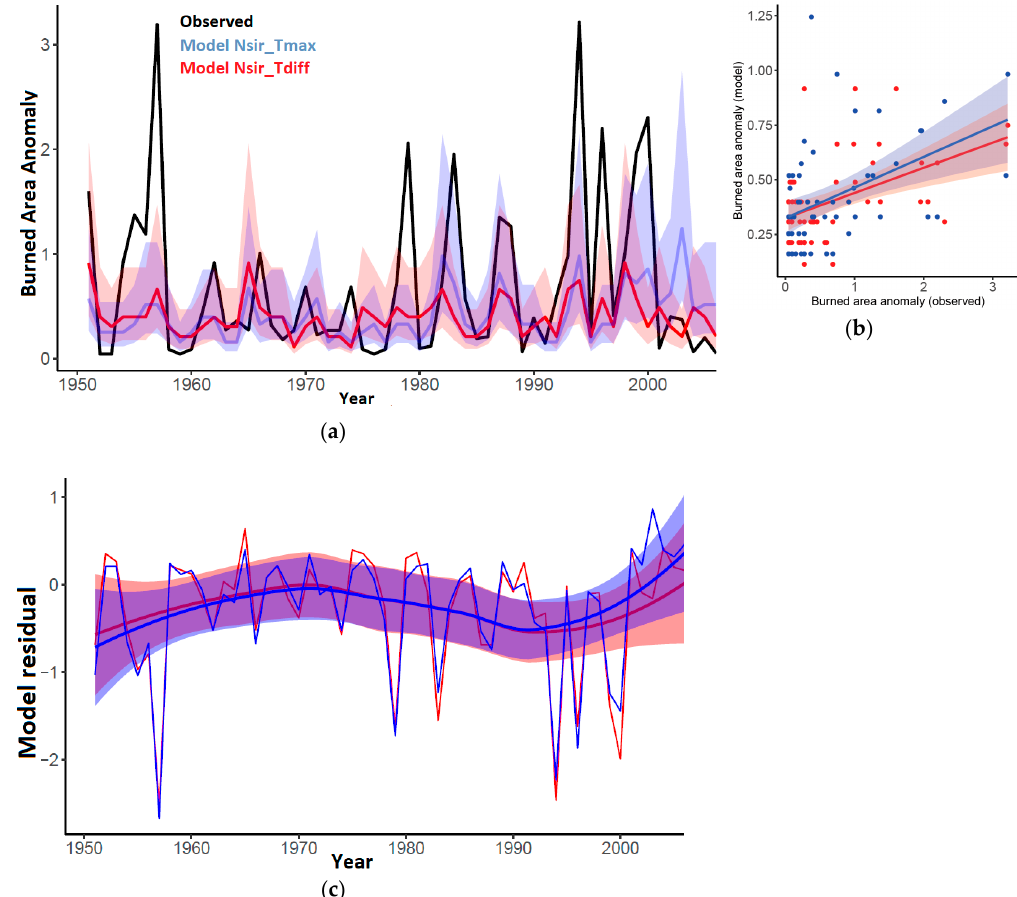
Figure 5. ( a ) Yearly burned area anomaly from 1950 to 2006 from observed data (black line) and simulated with the number of Sirocco events based on temperature anomaly (Nsir_Tdiff red line) and temperature threshold (Nsir_Tmax blue line). Shaded areas correspond to the uncertainty. ( b ). Correlations between observed and simulated burned area anomalies for the temperature anomaly (red dots) and temperature threshold (blue dots) ( c ) Yearly model residuals with a temporal locally weighted least square regression and 0.9 confidence interval (shaded areas) calculated frim ‘loess’ option in the ggplot2 ‘ geom_smooth ’ function. Table 1. Correlation coefficients (and significance level 1 ) and fraction of low/upper synchrony between yearly burnt area anomaly and fire hazard indices modelled from the number of Sirocco events based on temperature anomalies three days before and during fire events (Nsir_Tdiff), temperature anomaly above the 33 °C threshold (Nsir_Tmax) and the drought index Standardized Precipitation Evaporation Index (SPEI) (September). Levels indicate the temperature anomalies (in °C) or the number of months used for SPEI indices.